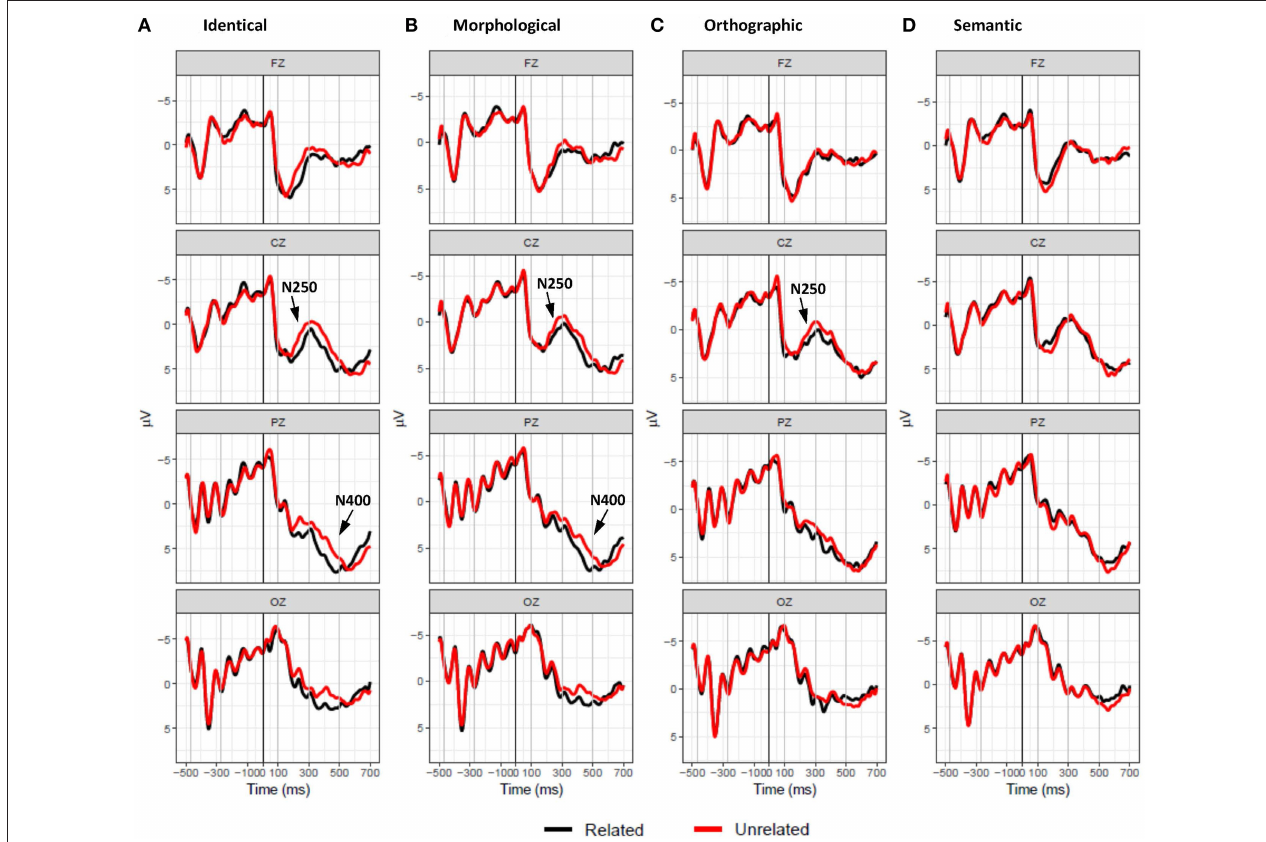
FIGURE 2 | Grand average ERPs at midline electrodes for (A) identity, (B) morphological, (C) orthographic, and (D) semantic conditions. The averages include data from all participants, L1 and L2. Black lines for related conditions, red lines for unrelated conditions. The baseline is − 470 to − 270ms (shown with gray lines). The prime appeared − 70 to − 20ms, followed by a mask − 20 to 0ms, and the target word, 0 to 600ms. global in its scalp distribution. Voltage maps are available in the Supplementary Material ( Datasheet 2